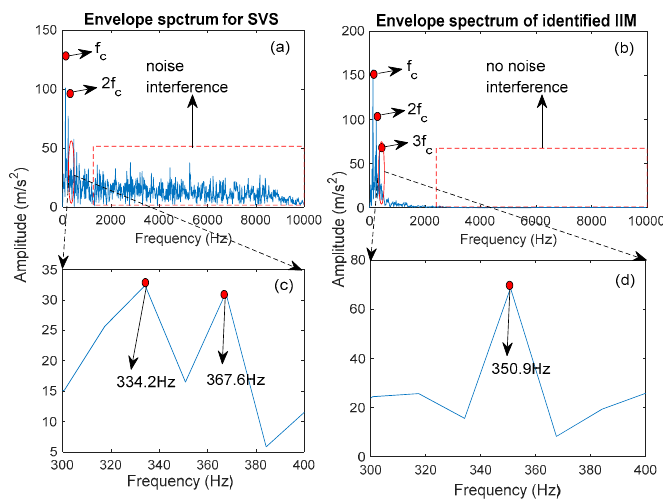
Figure 15. Comparison of fault frequency identification for the SVS signal and IIM. ( a , b ) the identified result of the feature frequency; ( c , d ) comprehensively shows the identified result.